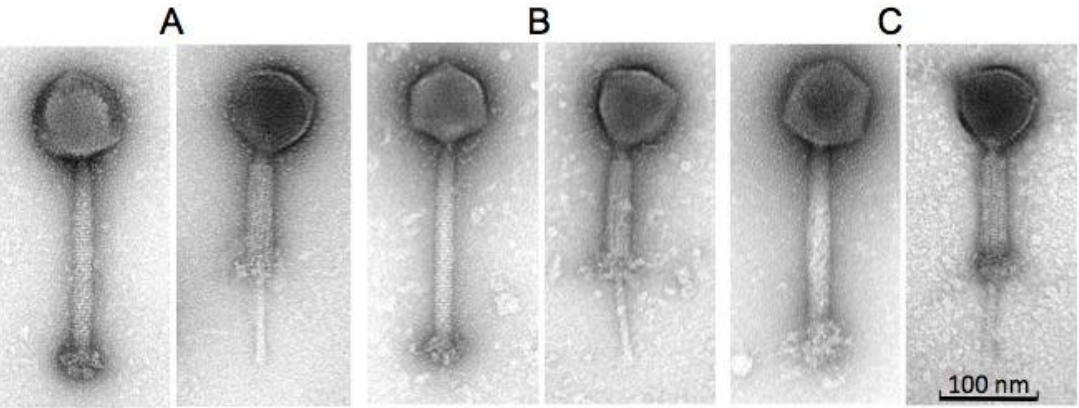
Figure 1. Transmission electron micrographs of phages B1 ( A ), JA1 ( B ), and K ( C ) showing their icosahedral capsid and their long contractile tail (both extended and contracted).